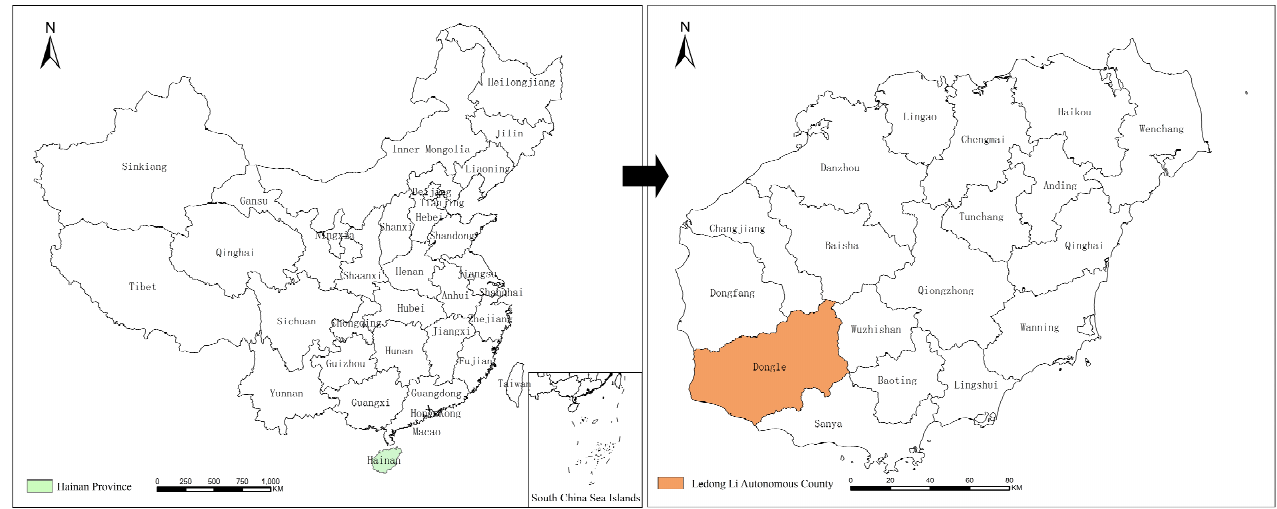
Figure 6. Study area: Ledong Autonomous County, Hainan Province.